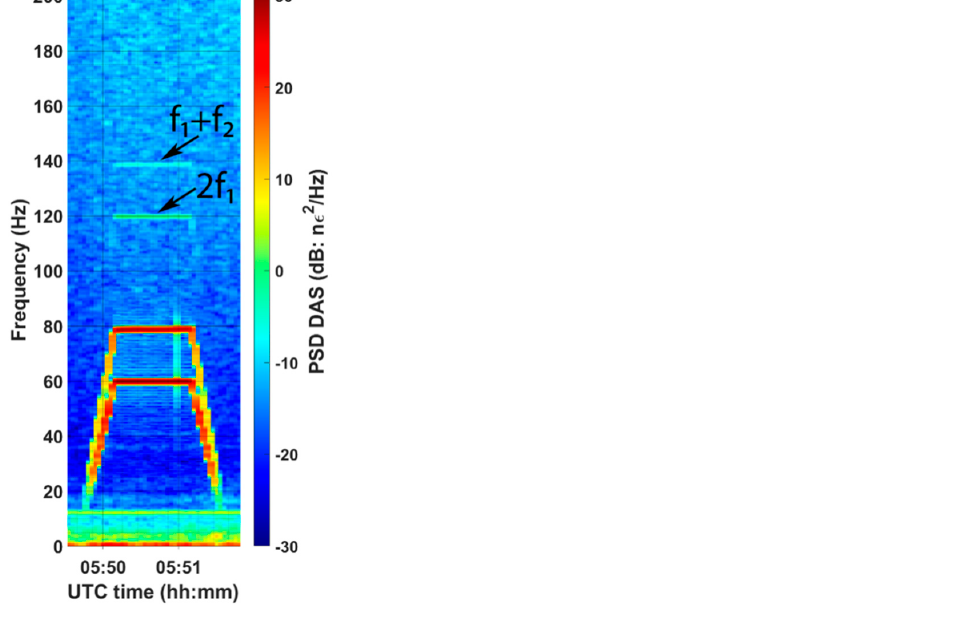
Figure 8. Power spectral densities of the DAS signals recorded 300, 500, 750, 1000, 1250, and 1500 m deep in the well during the warmup sequences of the SOV . Fifty sweeps were stacked together to increase the signal ‐ to ‐ noise ratio. The data also show 3 f 1 = 180 Hz and f 1 + f 2 = 140 Hz components of the wavefield as deep as 1500 m, which would have been unlikely had they been generated on the surface only. Additionally, these frequencies appear to decay slower than the fundamental fre ‐ quencies generated by the motors on the surface. These observations suggest that the non ‐ linear interaction of seismic waves occurs not only on the surface, but within the subsur ‐ face as well.